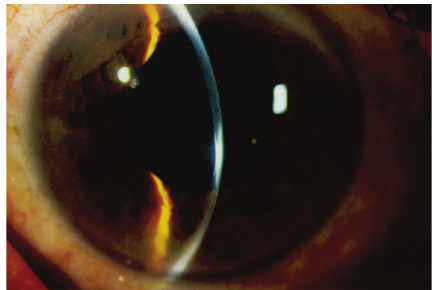
Figure 4: Retroillumination shows an irregularity with mosaic-like pattern. Note the sharp margin of the round lesion (arrow). There is a second sharp round line (arrowhead), forming a central and a peripheral zones.